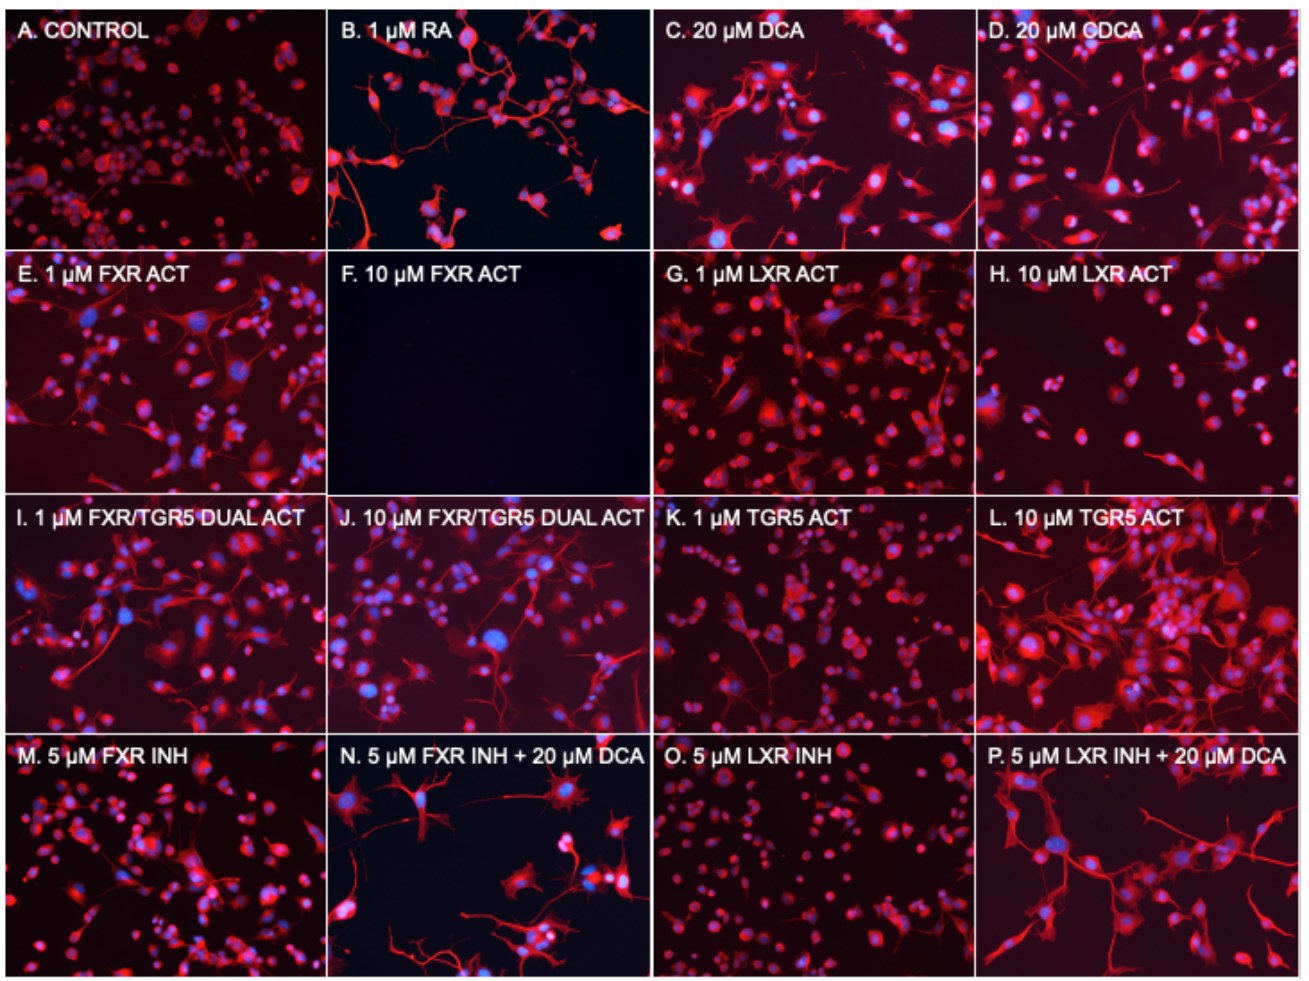
Figure 2. Photomicrographs of NSC-34 cells. ( A ) Basal medium. ( B ) 1 µ M RA. ( C ) 20 µ M DCA. ( D ) 20 µ M CDCA. ( E ) 1 µ M GW4064 (FXR Activator). ( F ) 10 µ M GW4064 (FXR Activa- tor). ( G ) 1 µ M WAY 252623 (LXR activator). ( H ) 10 µ M WAY 252623 (LXR activator). ( I ) 1 µ M